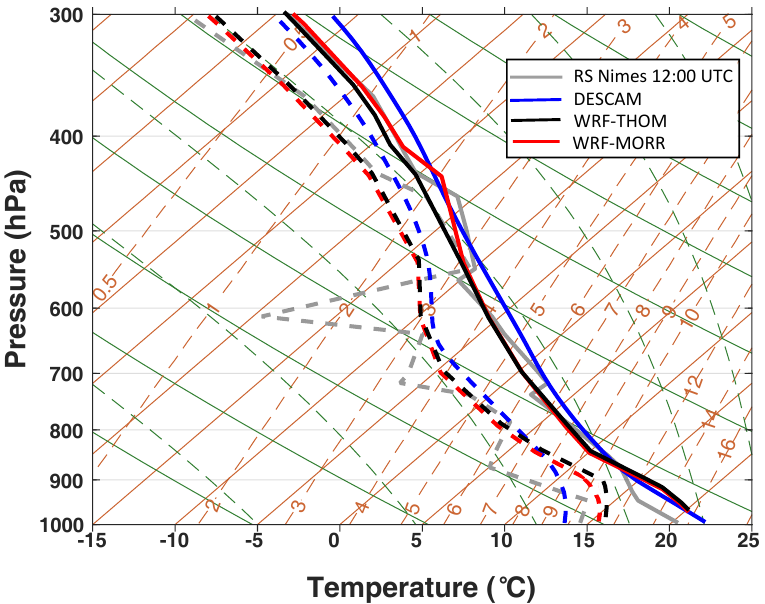
Figure 6. Mean vertical profiles of the temperature (solid lines) and the dew point temperature (dashed lines) between 07:00 and 12:00 UTC for the innermost domain with DESCAM, WRF-THOM and WRF-MORR simulations and obtained by the radio-sounding launched at Nimes on the 26th of Sept. 2012 at 12:00